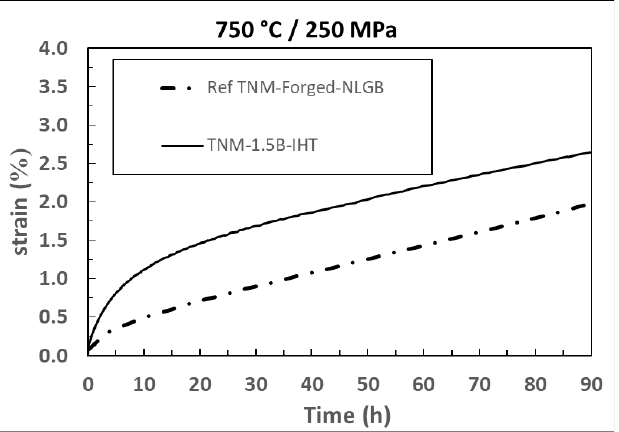
Figure 10. Creep curves at 750 °C and 250 MPa of both novel modified TNM IHT and conventional TNM-forged, after [6]. Table 4. Comparison of microstructural and mechanical properties of both novel modified TNM IHT and conventional